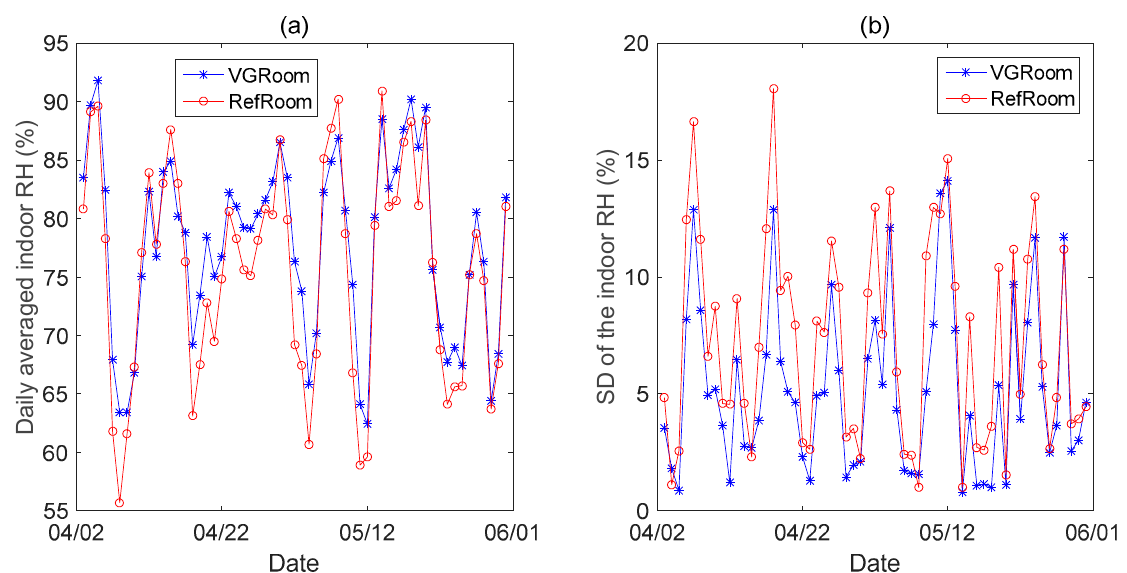
Figure 13. Daily averaged indoor air RH values ( a ) and their daily SD ( b ) during the experiment.